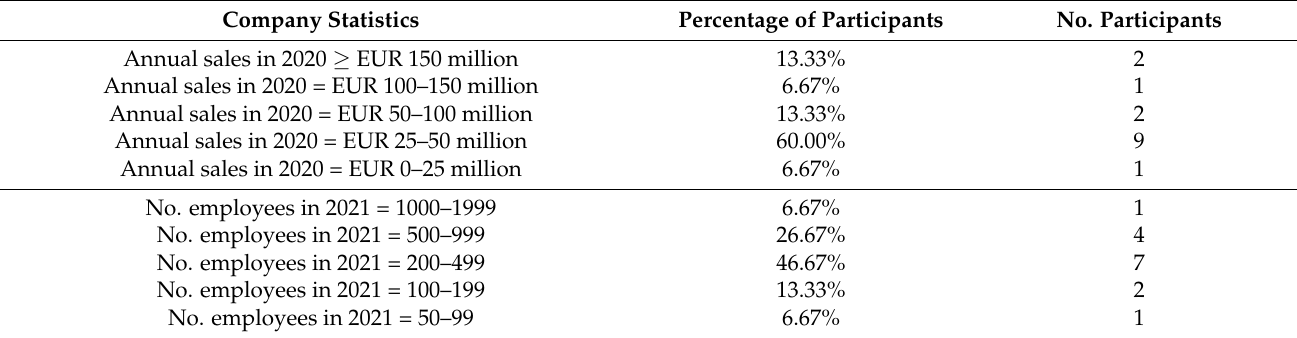
Table 4. Statistics of annual sales and number of employees of the companies where respondents